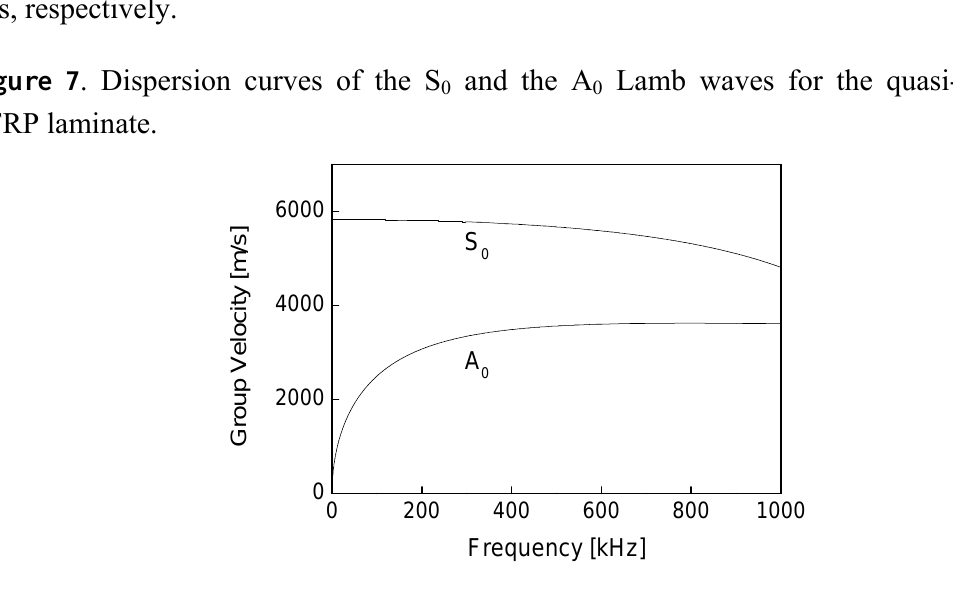
and the A Lamb waves for the quasi-isotropic 0 0